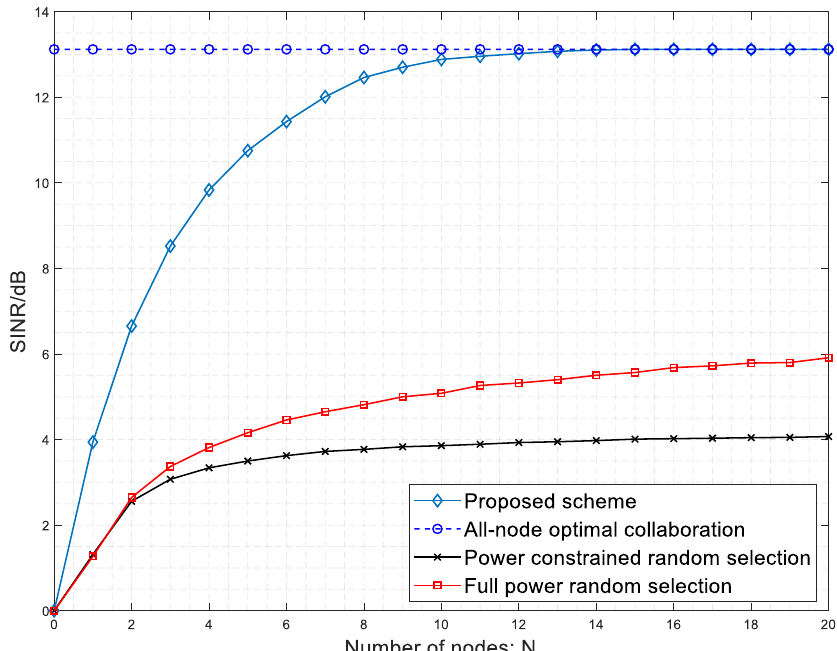
Figure 6. Comparison of SINR performance in four collaboration scenarios.